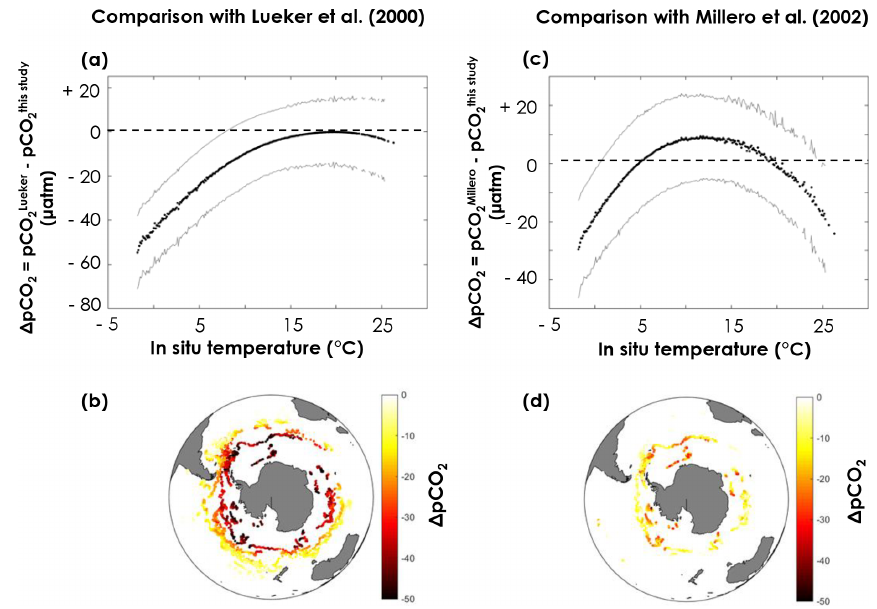
Figure 7. Difference in surface p CO 2 obtained from pH, temperature, practical salinity, and dissolved oxygen measured by the SOCCOM Argo array using (a, b) the Lueker et al. (2000) constants and the constants in Table 1 or (c, d) the Millero et al. (2002) constants and the constants in Table 1. Plots (a, c) represents the p CO 2 difference ( (cid:49)p CO 2 ) as a function of in situ temperature. Solid black lines are the mean (cid:49)p CO 2 , while solid grey lines are plus or minus σ(cid:49)p CO 2 (square root of the sum of the squares of σp CO Lueker Maps (b, d) depict the spatial distribution of (cid:49)p CO 2 in the Southern Ocean, where each point corresponds to an Argo float measurement.